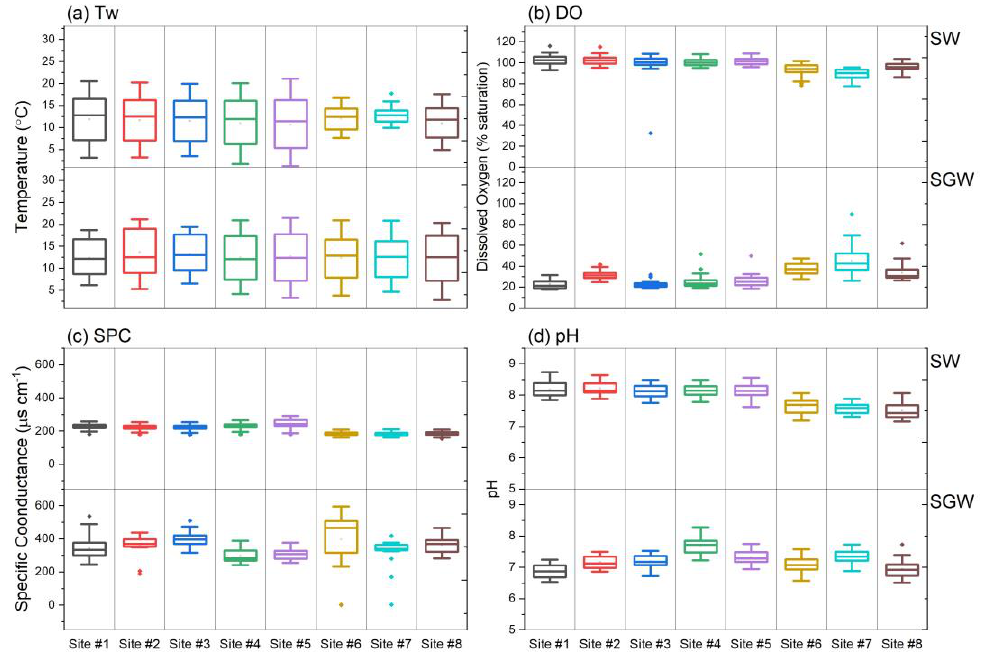
Figure 5. Box and whisker plots of stream water (SW) and shallow groundwater (SGW) physico- chemical variables [water temperature (Tw; °C), dissolved oxygen (DO;% saturation), specific con- ductance (SPC; µs cm − 1 ), and pH] during the study period (January 2020 − December 2021) for eight monitoring sites in Moore’s Run Watershed, Wardensville, W V, USA; box delineates 25th and 75th percentiles; line denotes median; open circle shows mean; whiskers delineate the range (i.e., 1.5 times the interquartile range); the filled circle indicates potential outliers.